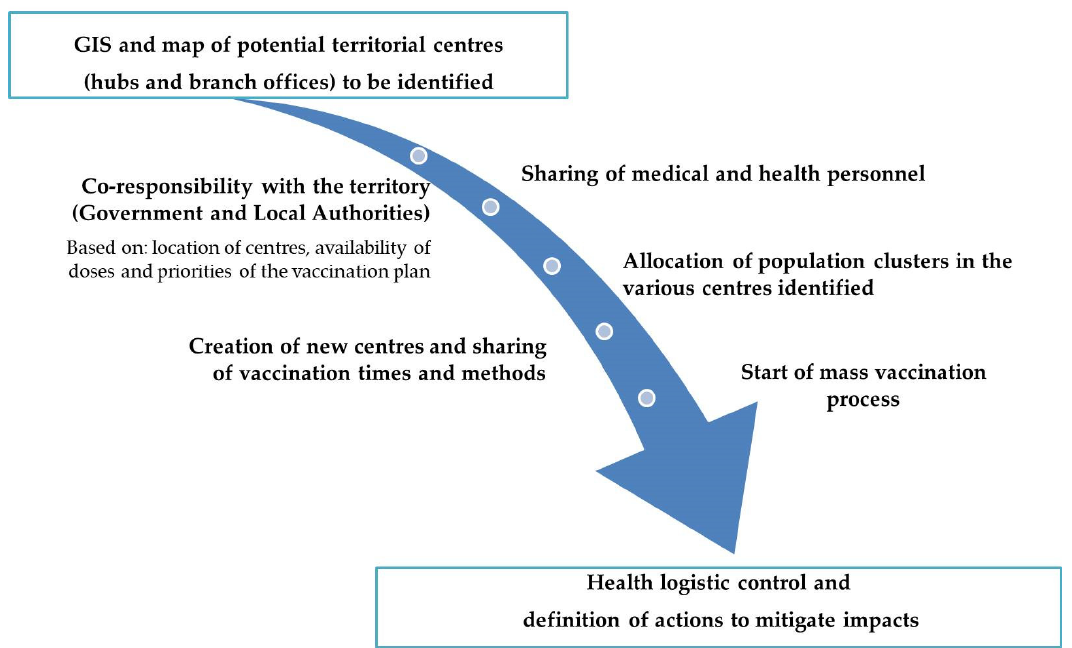
Figure 9. The development of GIS maps for the mitigation impacts of logistics post COVID-19 era.